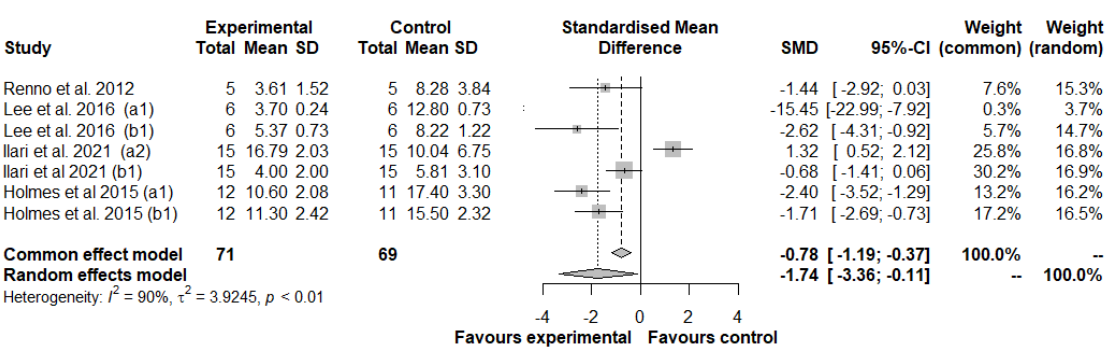
Figure 5. Forest plot showing the nutraceutical effects on thermal hyperalgesia by measuring the withdrawal latency in the two paws. SD, standard deviation; SMD, standardized mean differences; CI, confidence interval.